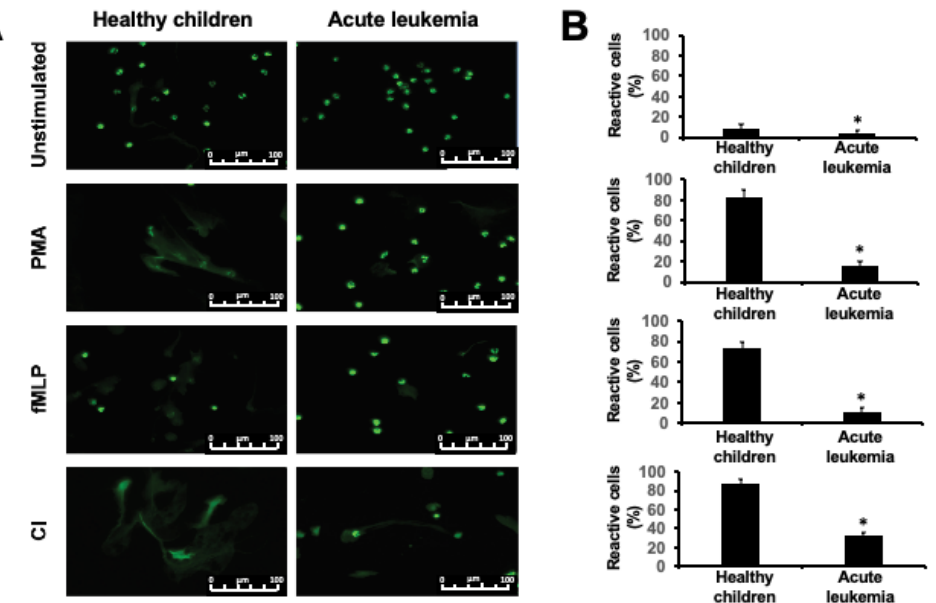
Figure 2. Microscopic evaluation of NET release in vitro in children with acute leukemia and healthy controls. ( A ) Representative fluorescent microscopy images of neutrophils isolated from healthy children and acute lymphoblastic leukemia (right column) stimulated with PMA, fMLP, and CI stained with SYTOX-green dye for extracellular DNA. ( B ) Bar plots represent the results of manual morphological evaluation of the number of reactive (NETotic) cells in fluorescent microscopy. The results are shown as mean value +SD of n = 28 and n = 30 samples (for healthy children and leukemic children, respectively). * p < 0.001 (two-tailed t test). Scale bars show 100 um.